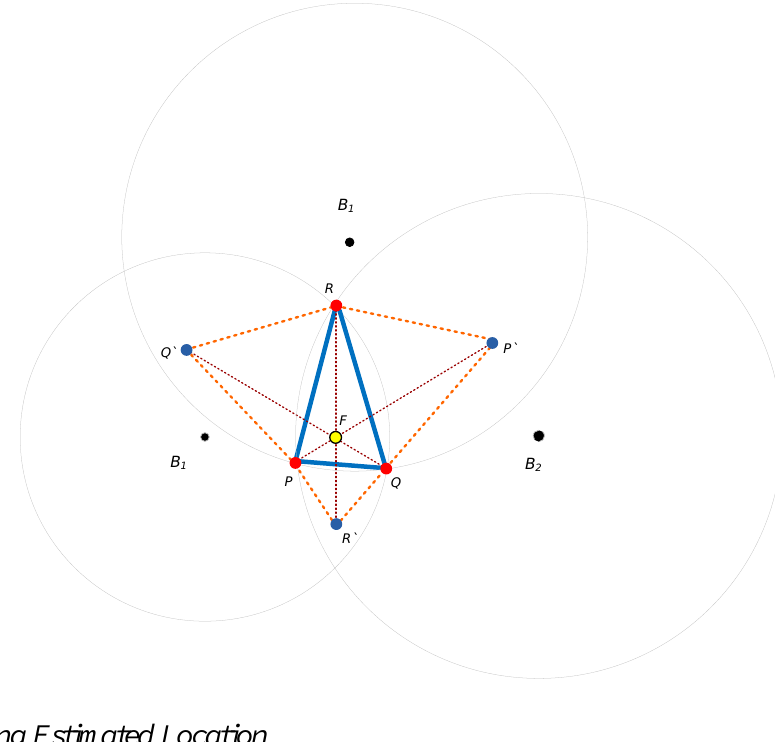
Figure 6. Formation of Three Virtual Triangles associated with Fermat Point.